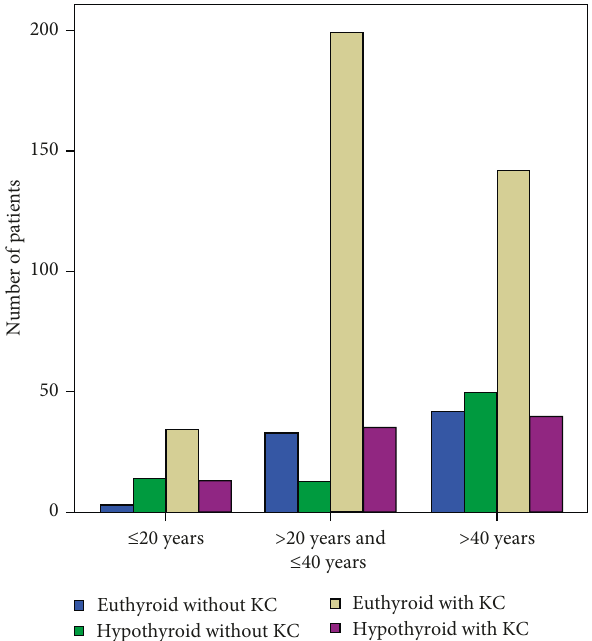
Figure 1: The disease distribution in different age